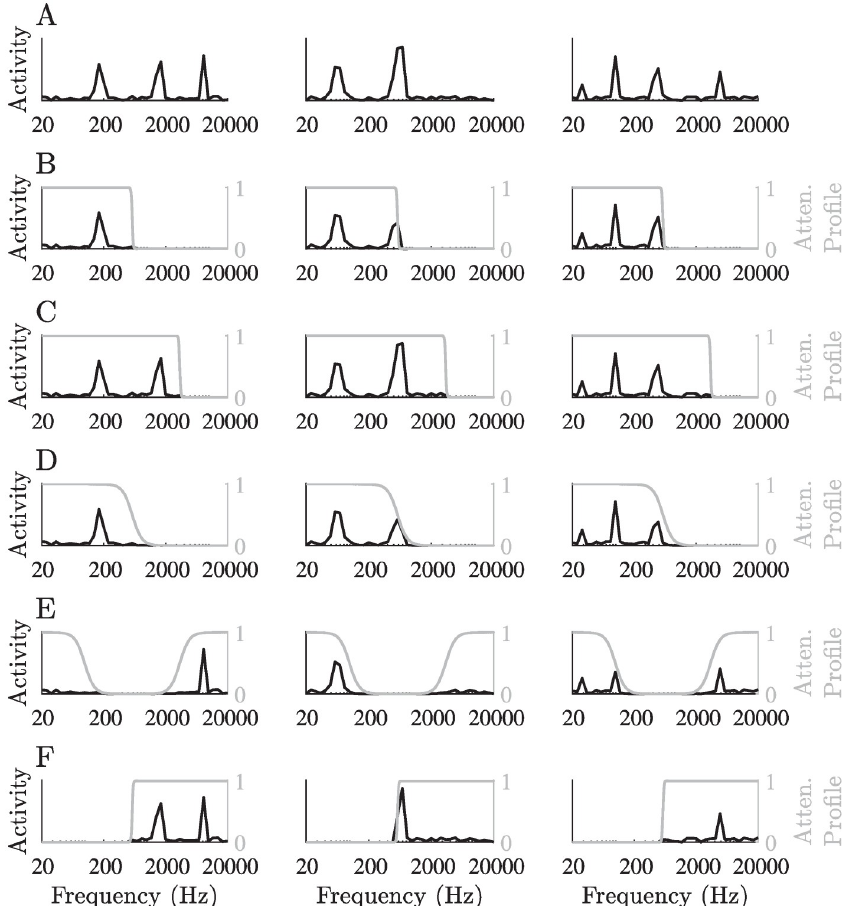
Fig 2. Typical stimuli. A: Three examples of typical simulated stimuli, representing the activity of the input neurons as a function of their preferred frequency. B–F: The stimuli presented in A, after attenuation of different frequency ranges using different attenuation profiles. Attenuation was achieved by multiplying the original input vector by an attenuation profile, depicted in gray. The attenuation profiles in B–D and F were inverted sigmoidal functions with parameters k 0 = 20, β = 10 for B, k 0 = 30, β = 10 for C, k 0 = 20, β = 1 for D and k 0 = 20, β = − 10 for F, where k 0 represents the transition frequency (in the input neurons domain, between 1 and M = 40) and β represents the sharpness of the transition. The attenuation profile in E was composed of two sigmoidal functions with parameters k 1 = 10, k 2 = 30, β = 1. For further details, see